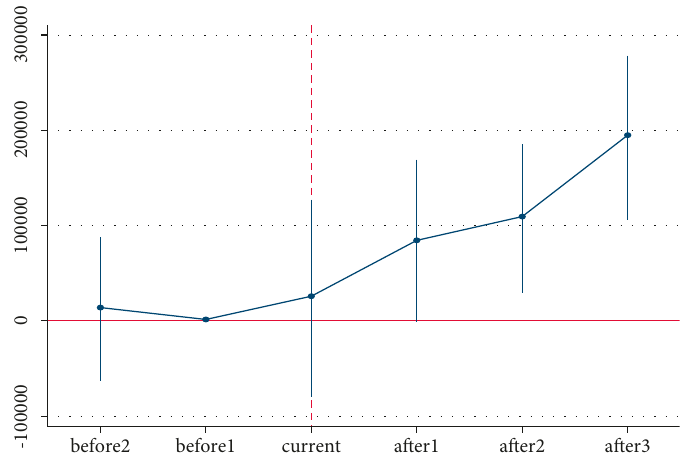
Figure 5: Parallel trends in domestic and inbound tourism